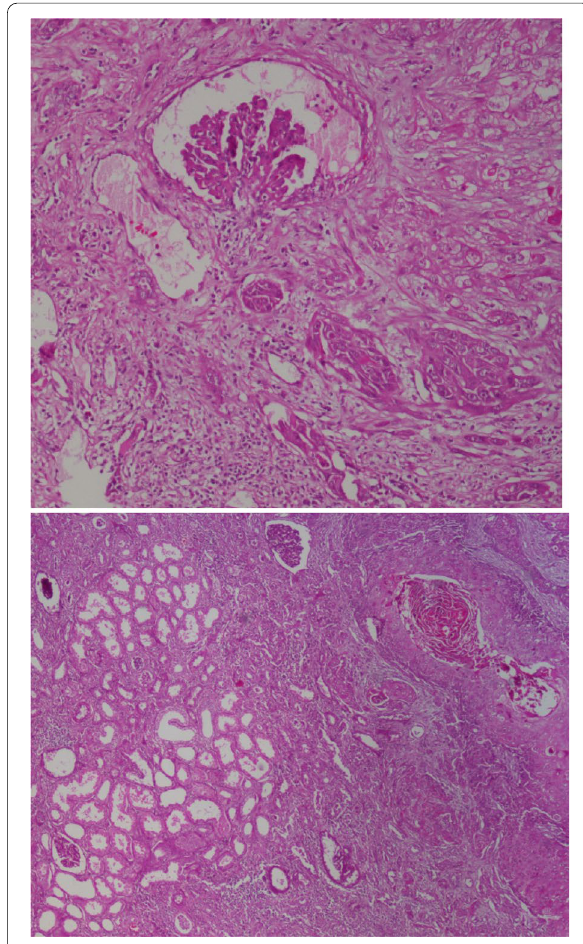
Fig. 3 Histopathological slide: Well-differentiated squamous cell carcinoma. Tumor infiltrates renal parenchyma, perinephric fat and periureteric